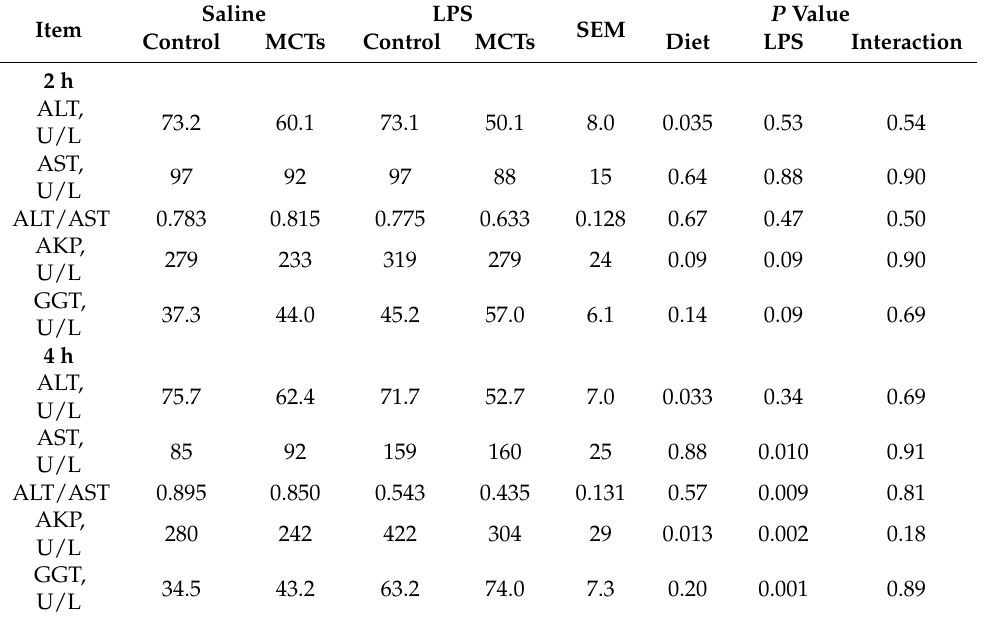
Table 1. Effect of medium-chain triglyceride (MCT) supplementation on serum biochemical parameters after 2- or 4-h LPS challenge in pigs *.